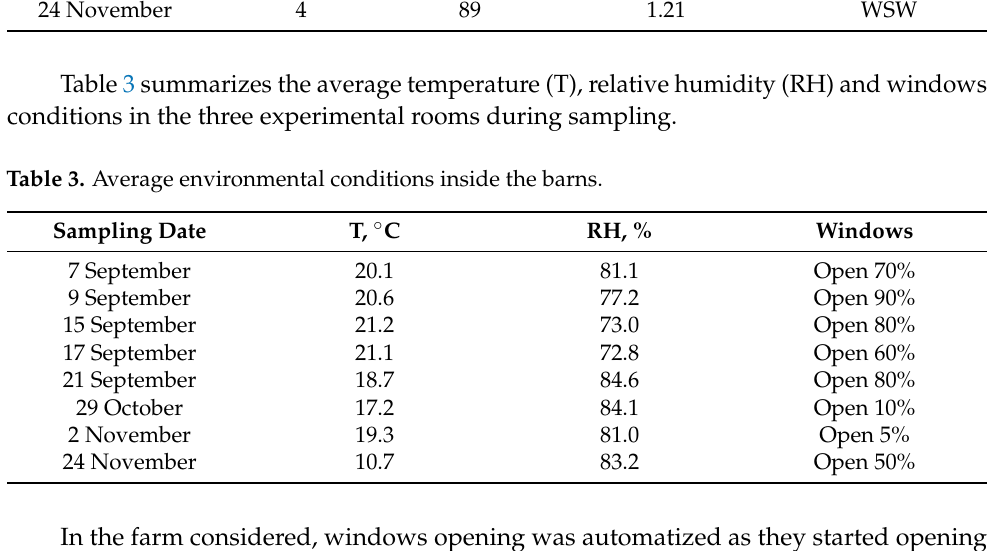
Table 3 summarizes the average temperature (T), relative humidity (RH) and windows